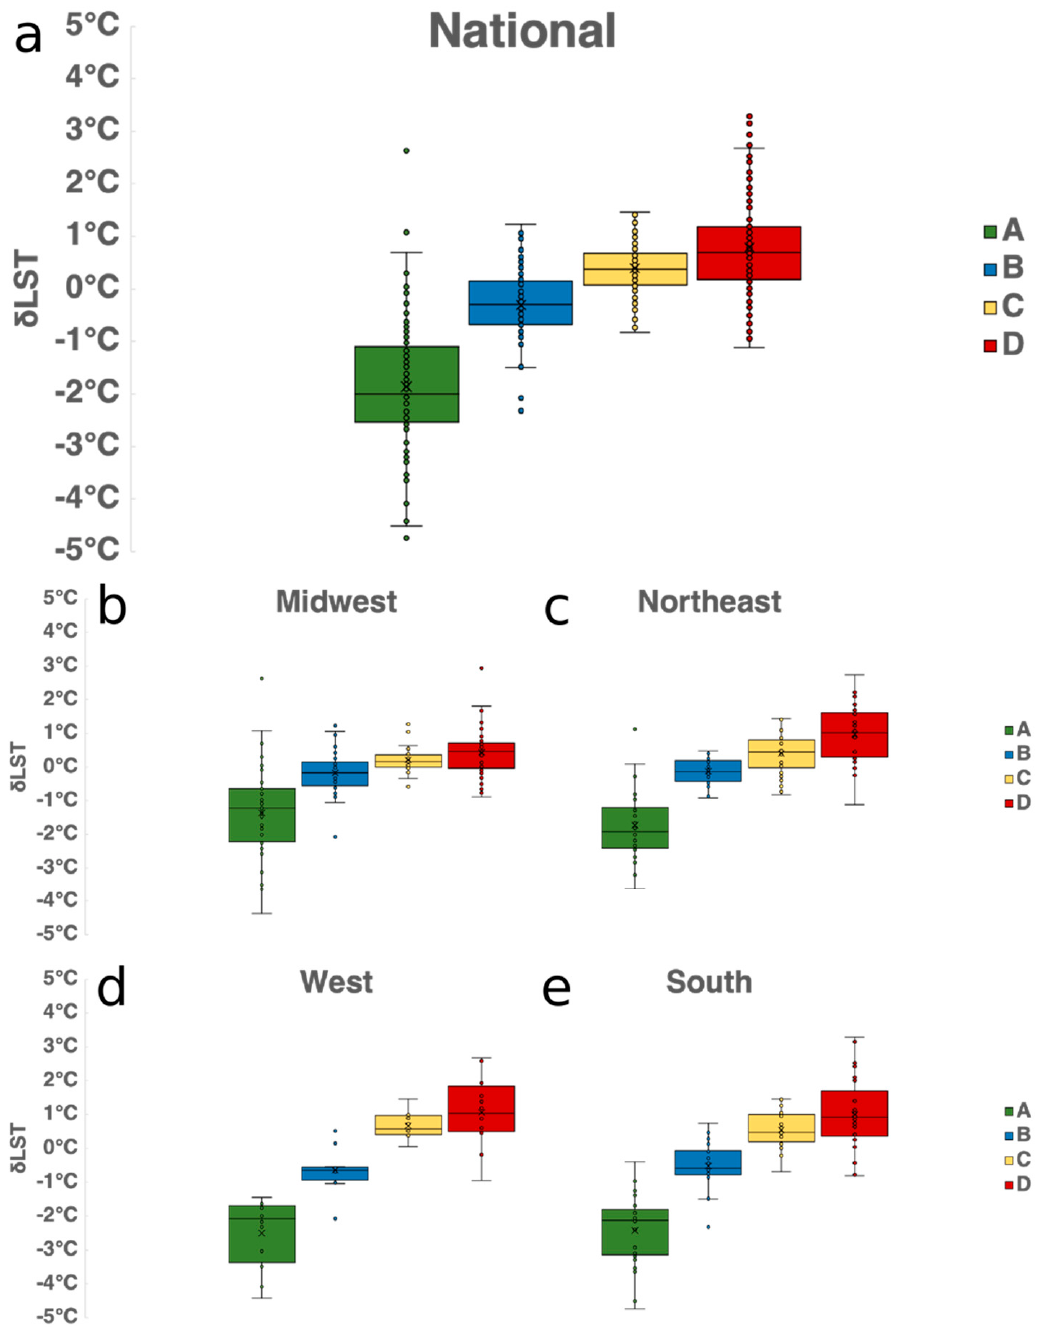
Figure 3. ( a ) National-scale Land Surface Temperature Anomalies by HOLC security rating (Green, “Best,” A; Blue, “Still Desirable,” B; Yellow, “Definitely Declining,” C; Red, “Hazardous,” D) ( b ) same as ( a ) , but for the Midwest region; ( c ) same as ( b ), but for Northeast region; ( d ) same as ( b ), but for West region; ( e ) same as ( b ), but for South region.